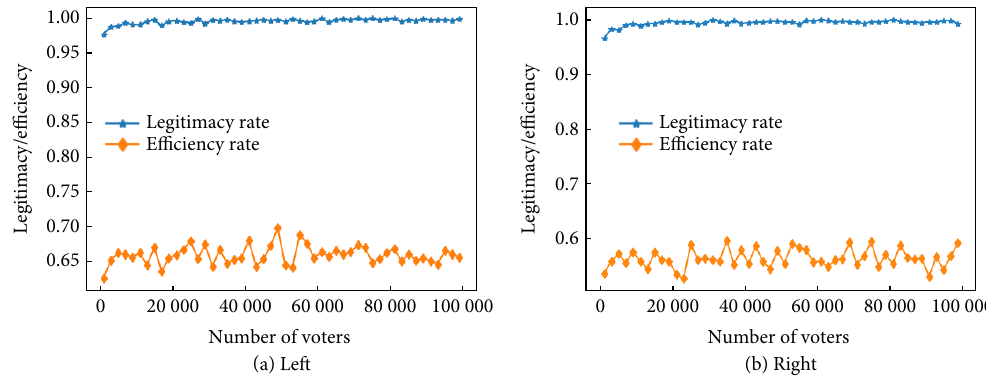
Fig. 10 Line chart of changes in the number of candidates.